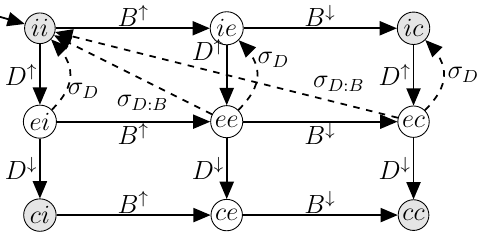
Figure 8. Parallel execution of operations B and D . Placement transitions for D are dashed.